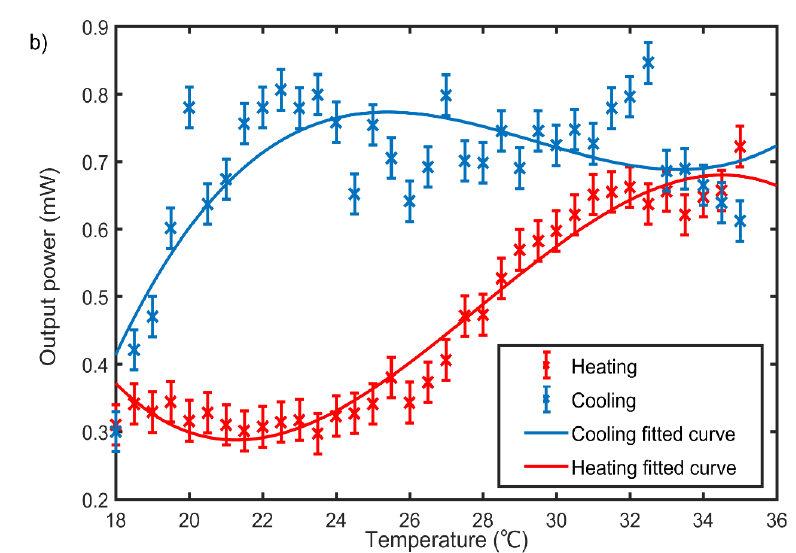
Figure 7. ( a ) Output power measured as a function of ambient temperature of the polymer waveguide without the molecular complex material. The residual variation of the power is neglected at this stage and will be studied in more detail in future studies. ( b ) Switching behavior of the polymer waveguide containing the iron complex as a function of ambient temperature, detected by measuring the output power during the heating and cooling cycles. The hysteresis memory effect is clearly visible.